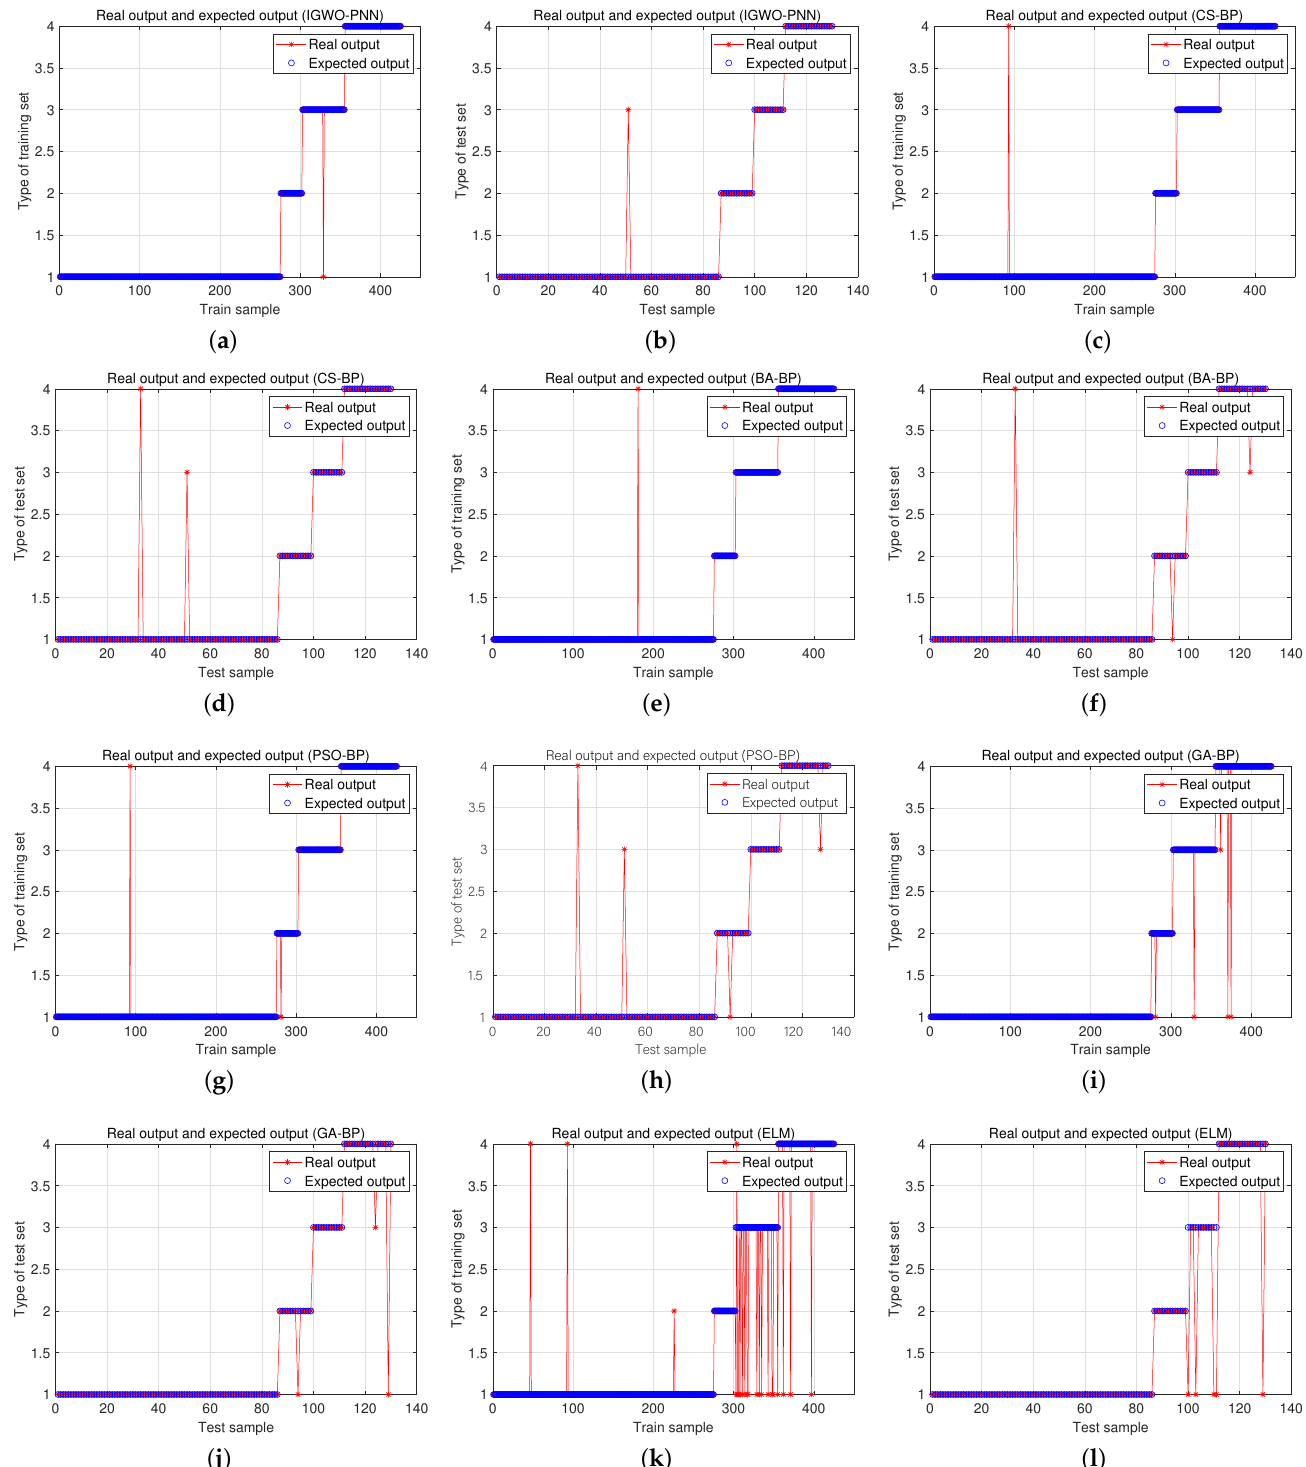
Figure 11. Comparison of the diagnosis results of the third set of comparative experiments. ( a , c , e , g , i , k ) represent the results of train sample classification for different methods, respectively. ( b , d , f , h , j , l ) are the results of testsample classification for different methods, respectively.